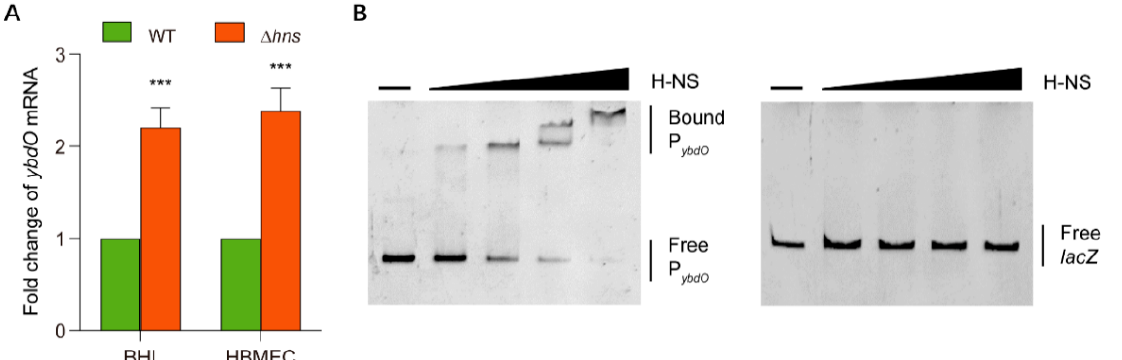
Figure 6. H-NS directly repressed ybdO expression. ( A ) Fold change in ybdO mRNA levels in the WT and Δ hns strains. ( B ) EMSAs of the specific binding of H-NS to P ybdO and lacZ (negative control). PCR products were added to the binding buffer at 20 ng each, and H-NS protein was added to the reaction buffer (lanes 1–5) at 0, 0.125, 0.25, 0.5, and 1 μ M. Data were obtained from three independ- ent experiments and analyzed using Student’s t- test. *** p < 0.001.